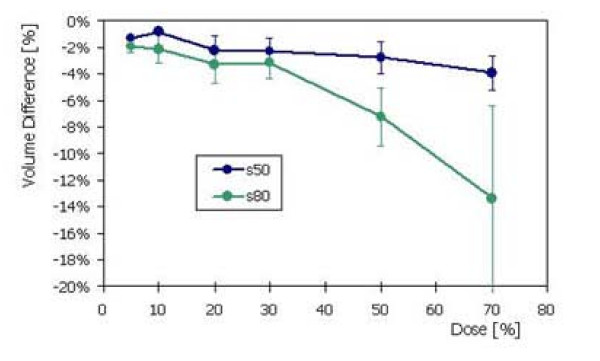
Healthy tissue analysis: volumetric differences for the s50 (or s80) plans and the s25 plans, as a function of different dose levels.